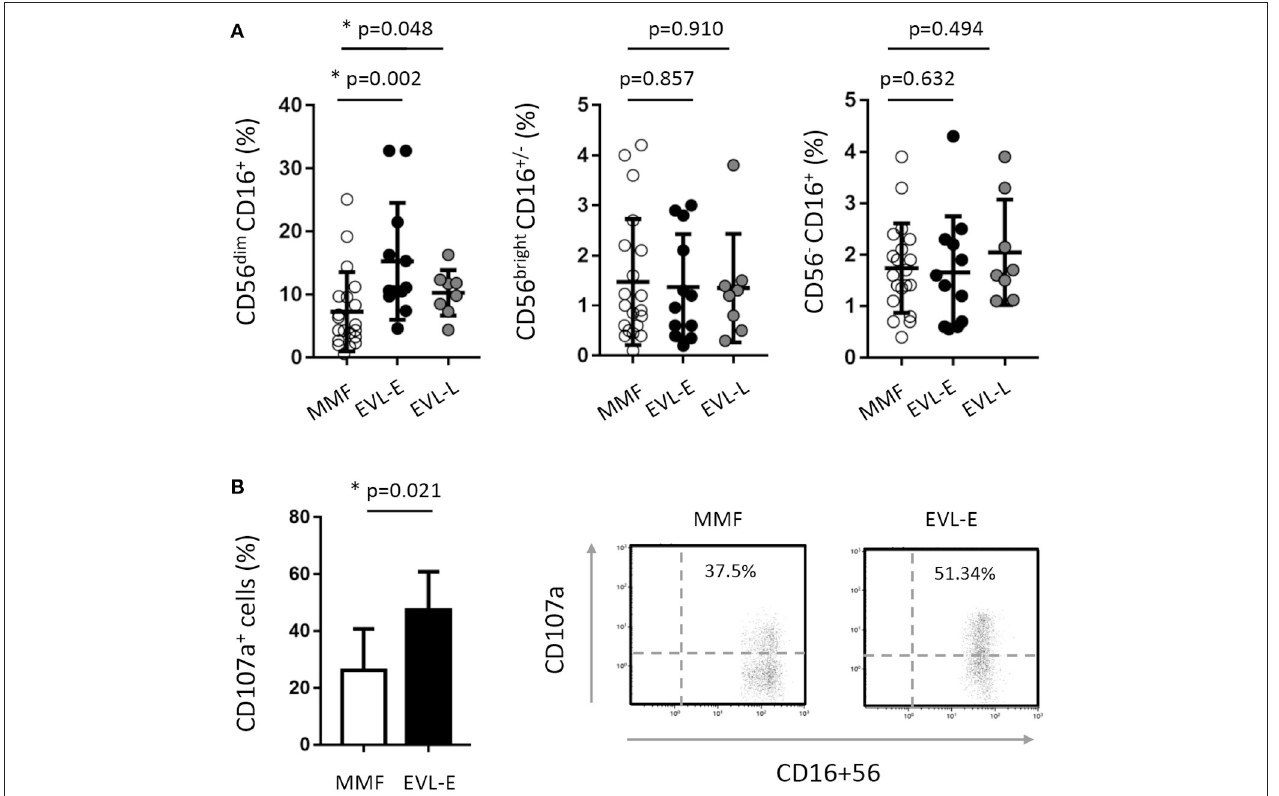
FIGURE 4 | Effect of EVL on the subsets and functionality of NK cells. (A) Distribution of NK cell subsets into CD56 dim CD16 + (cytotoxic cells), CD56 bright CD16 + / − (cells producing cytokines) and CD56 − CD16 + (cells expanded in chronic viral infections) in HT patients from the MMF ( n = 20), EVL-E ( n = 12) and EVL-L ( n = 8) groups. Each circle represents one HT patient, and the mean and standard deviation are depicted as black bars. Significant differences between groups were determined by the Mann–Whitney U -test. * p < 0.05. (B) Degranulation (CD107a + cells) of NK cells under activation with IL-2 + IL-15 cytokines for each patient from the MMF ( n = 20) and EVL-E ( n = 12) groups. Significant differences between groups were determined by Student’s t -test or the Mann–Whitney U -test. * p < 0.05. Dot-plots show one representative experiment of each